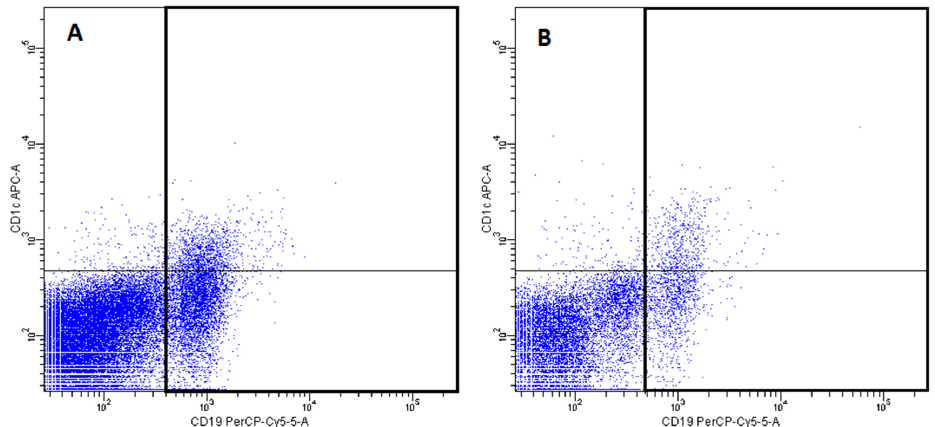
Figure 14. Exemplary plots of flow cytometry analysis showing the staining with antibodies specific for CD3 (T lymphocytes—red gates) and CD14 (monocytes—green gates) in mononuclear leukocyte fraction: ( A ) peripheral blood ( B ) FNAB.